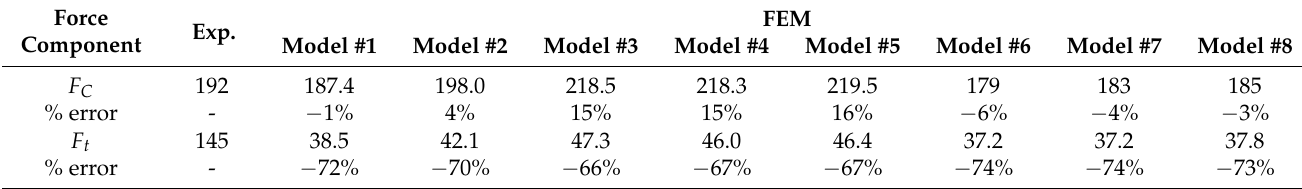
Table 3. Specific cutting force magnitudes